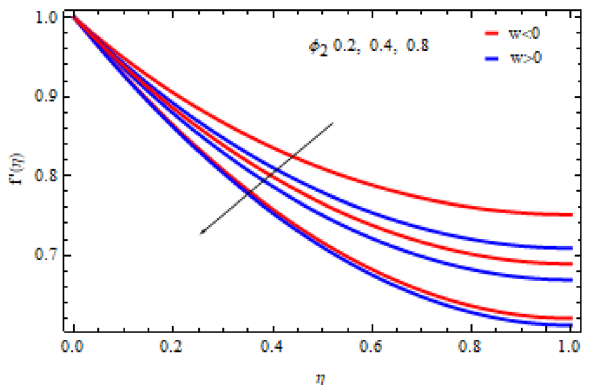
Figure 6. Velocity field by φ 2 .